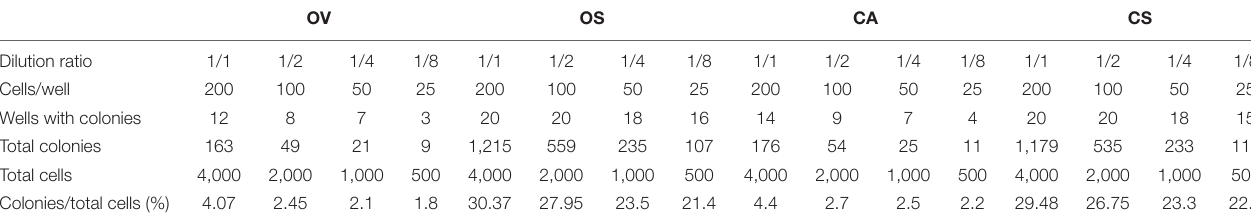
TABLE 1 | Limited gradient dilution analysis experiment for OV, OS, CA and CS. OV